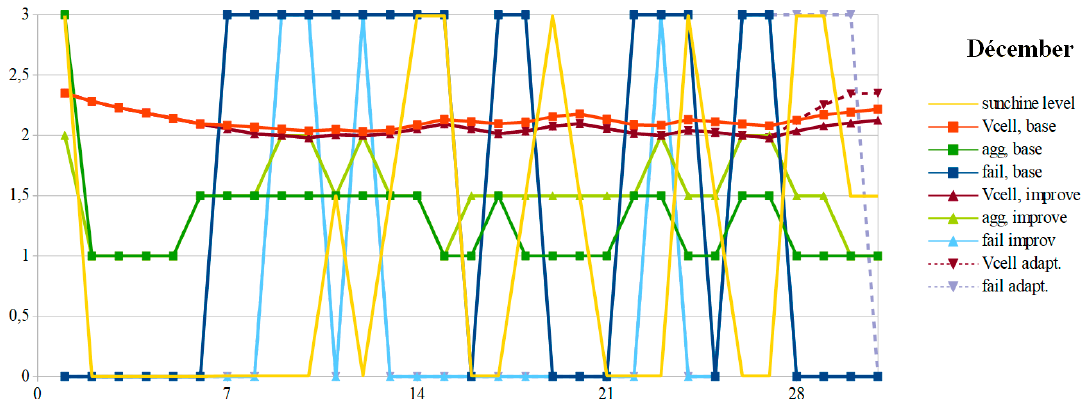
Figure 8. Simulated variations in OCV, failure, and aging aggravation, with or without the suggested improvements slopes, in December.